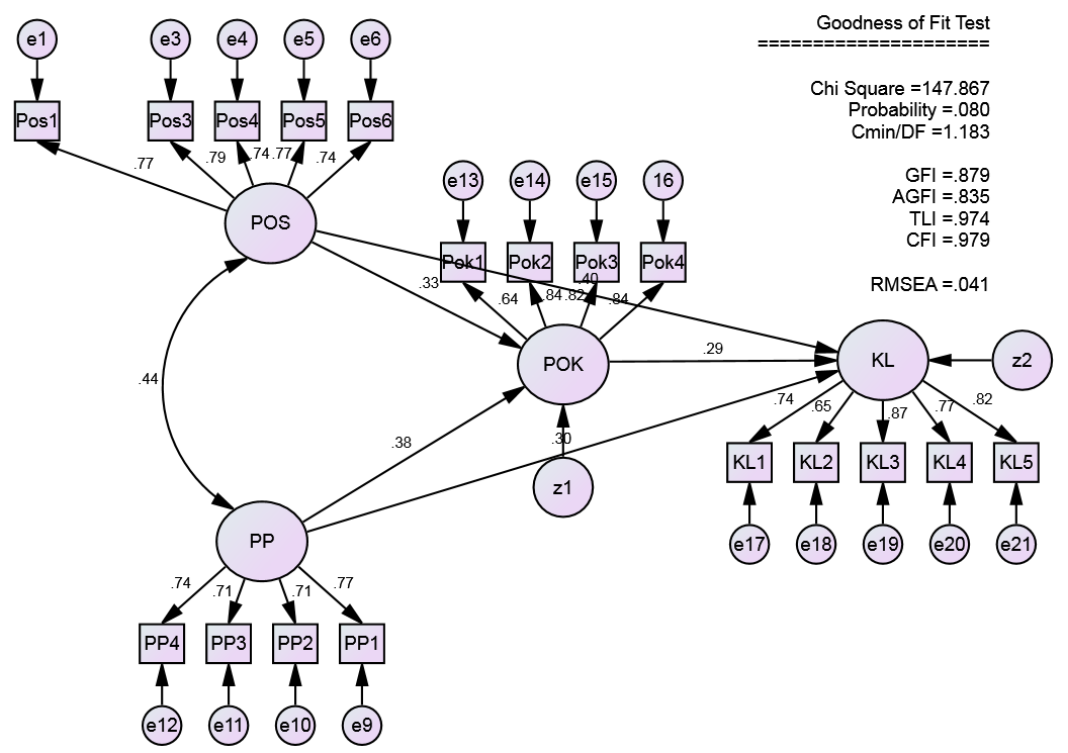
Figure 1 : Hypothesis Test Results Based on the Research Model